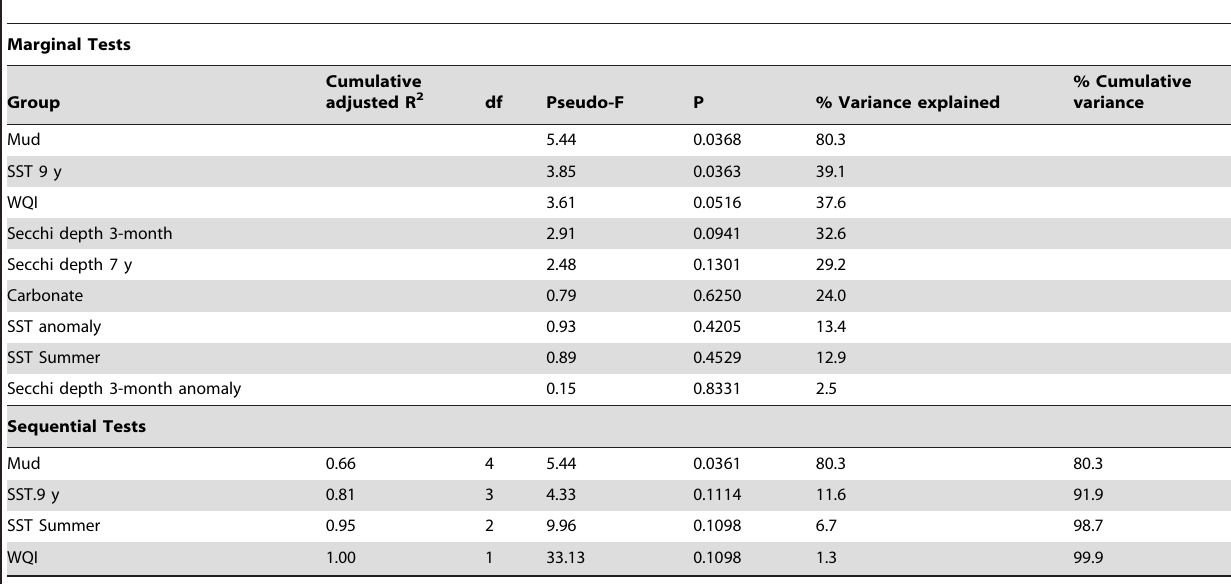
Predictors selected by stepwise selection of terms for the model with the best fit based on adjusted R 2 .